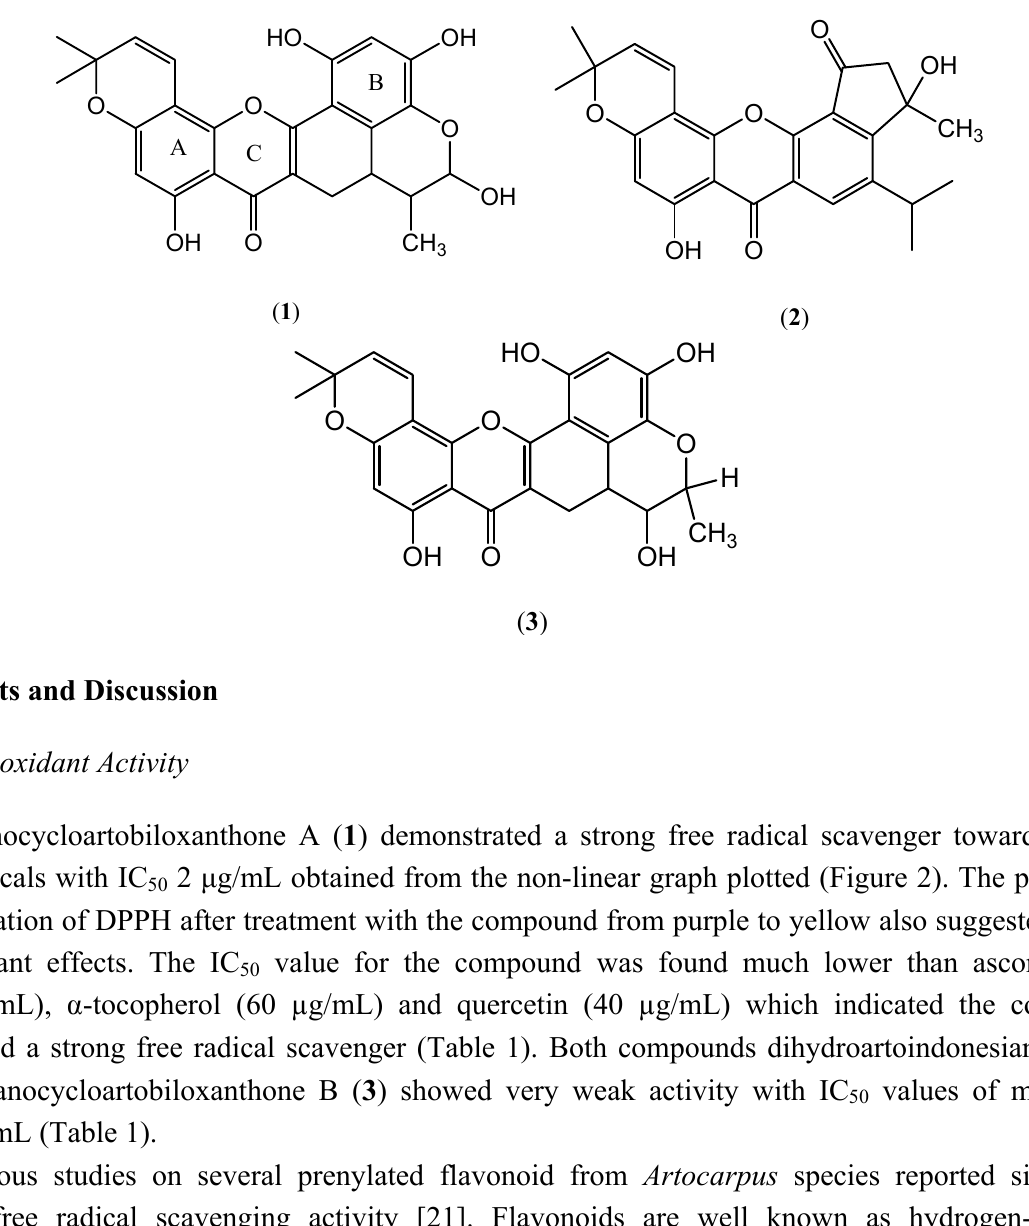
Figure 1. Chemical structures of pyranocycloartobiloxanthone A ( 1 ), dihydroartoindonesianin C ( 2 ) and pyranocycloartobiloxanthone B ( 3